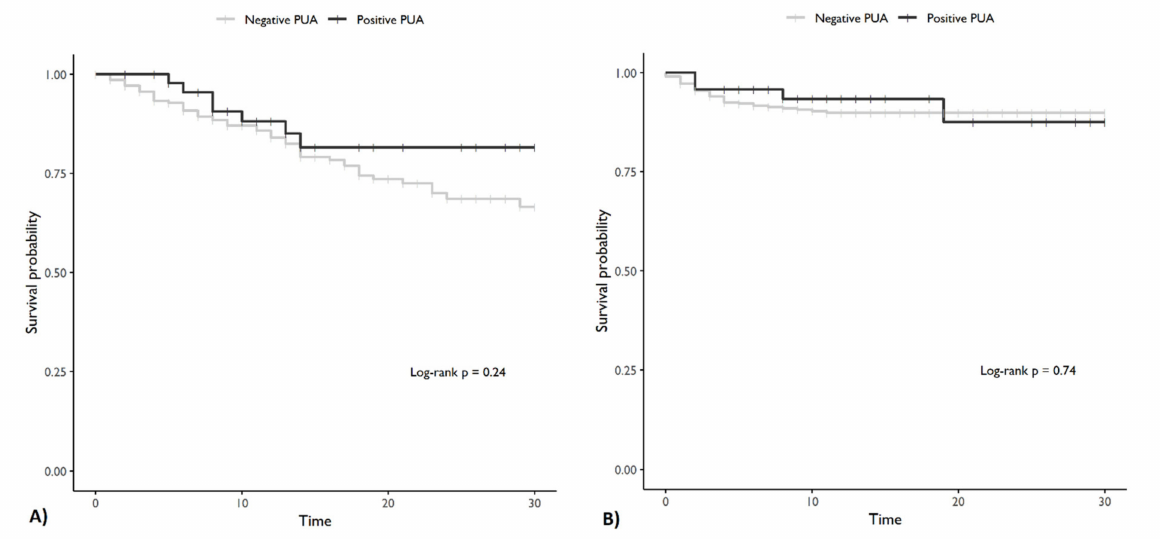
Figure 1. Survival curves. ( A ) Survival curve for death. ( B ) Survival curve for ICU admission. Note: PUA = pneumococcal urinary